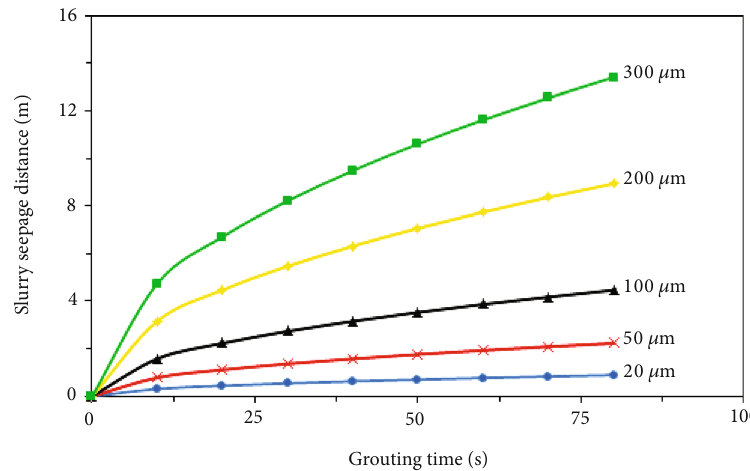
Figure 11: Slurry seepage distance for di ff erent fracture openings with fl uid-solid